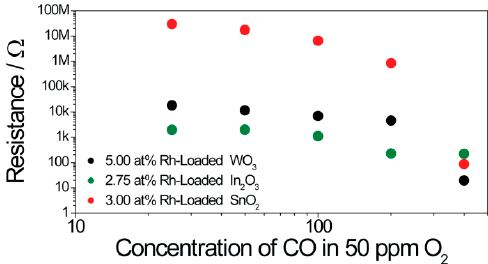
Figure 11. The change in resistance of the sensors during exposure to different CO concentrations in low-oxygen background, acquired during simultaneously measured X-ray absorption spectroscopy (XAS), is plotted in log-log.